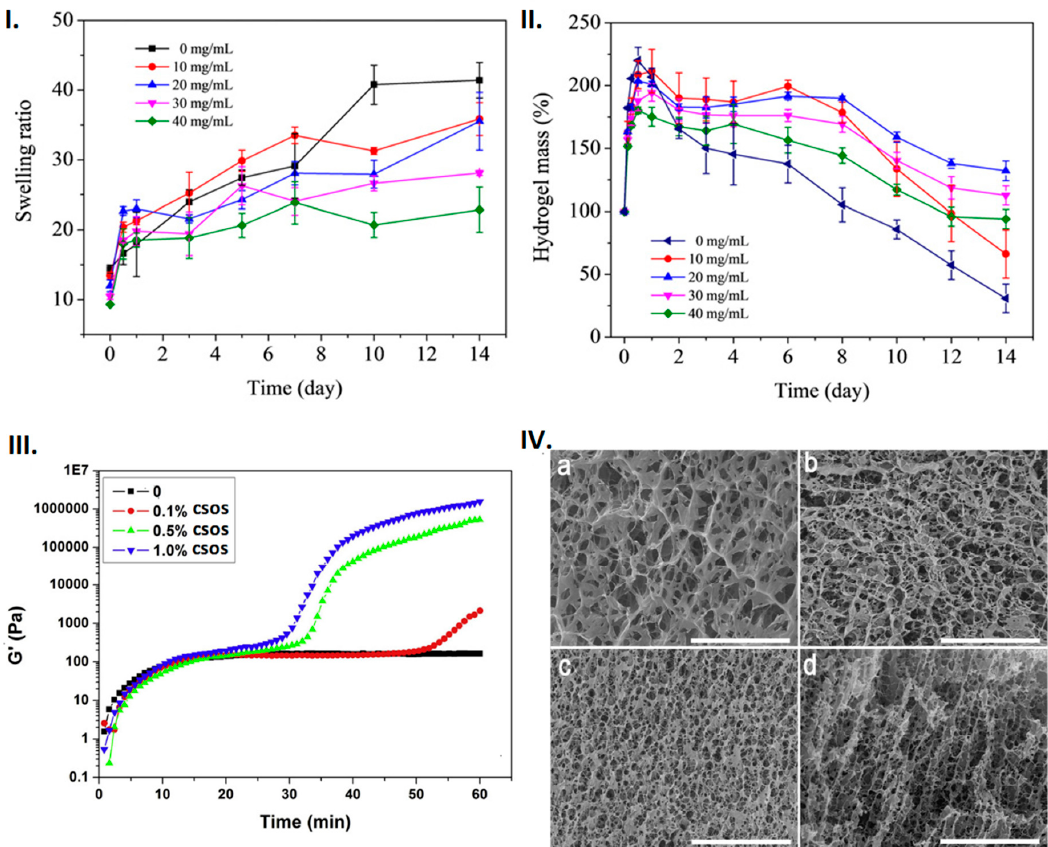
Figure 4. Physical and mechanical properties of the chitosan-based composites: ( I ) Swelling and ( II ) degradation kinetics of tetracycline hydrochloride (TH) / oxidised alginate (OAlg) / carboxymethyl chitosan (CMCS) / gelatine microspheres (GMs) gel with di ff erent concentrations of GMs as a function of time in PBS at 37 ◦ C. Image reproduced with permission from Chen et al. [36]. ( III ) Gelling kinetics (of carboxymethy chitosan (CMCS) / alginate / chitosan oligosaccharides (CSOS) hydrogels at di ff erent CSOS concentration; ( IV ) Porosity observed in SEM images of CMCS / alginate (1:1) hydrogels with di ff erent concentration of CSOS: ( a ) no COS 0.1%, ( b ) CSOS, ( c ) 0.5% CSOS, and ( d ) 1.0% CSOS; (scale bar = 40 µ m). Image reproduced with permission from Lv et al.